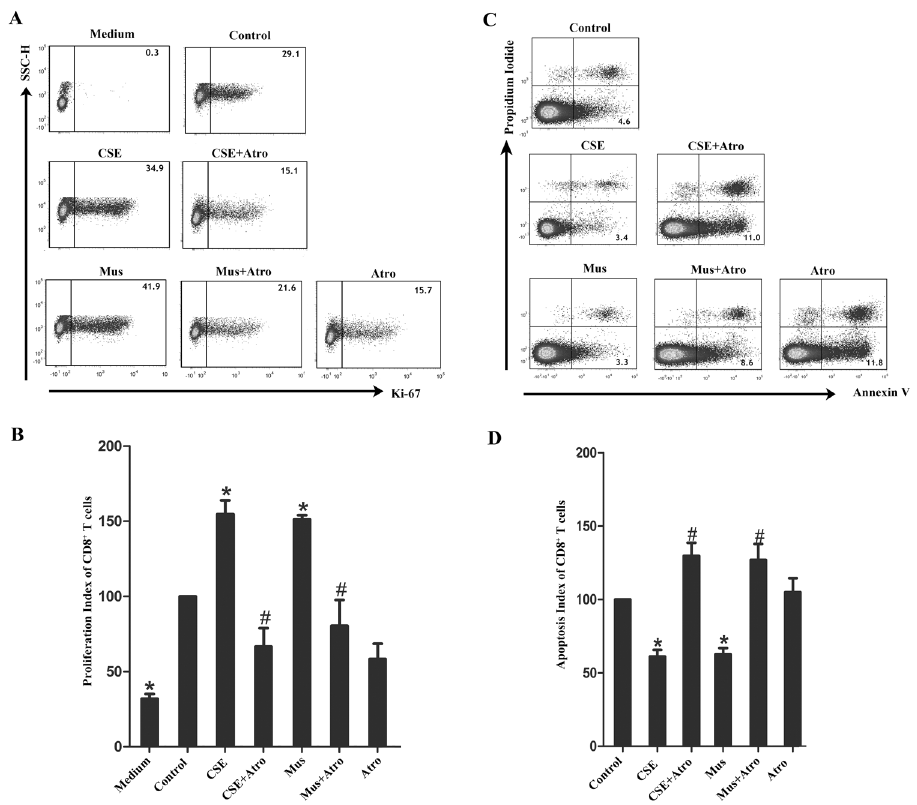
Fig 3. Effects of CSE and muscarinic receptors on proliferation and apoptosis of CD8 + T cells. PBT cells from healthy nonsmokers were cultured for 5 days in the presence of CSE and MRs agonist/antagonist, either alone or in various combinations. (A) In the proliferation assays, medium combined with PHA and PMA was considered as control treated wells. Ki-67 + CD8 + T cells (excluding CD8 + Tregs) were examined by flow cytometry, and the representative flow cytometric dot plots are shown. (B) The proliferation index of control wells was considered to be 100, and data are expressed as fold increase relative that in the control wells (n = 5). (C) In the apoptosis assays, medium alone was considered as control treated wells. Apoptotic CD8 + T cells (excluding CD8 + Tregs) were examined by flow cytometry, and the representative flow cytometric dot plots are shown. (D) The apoptosis index of control wells was considered to be 100, and data are expressed as fold increase relative that in the control wells (n = 6). The results are reported as the mean ± SEM. * P < 0.05 compared with the control wells; #P < 0.05 indicates CSE plus Atro compared with CSE or Mus plus Atro compared with Mus.